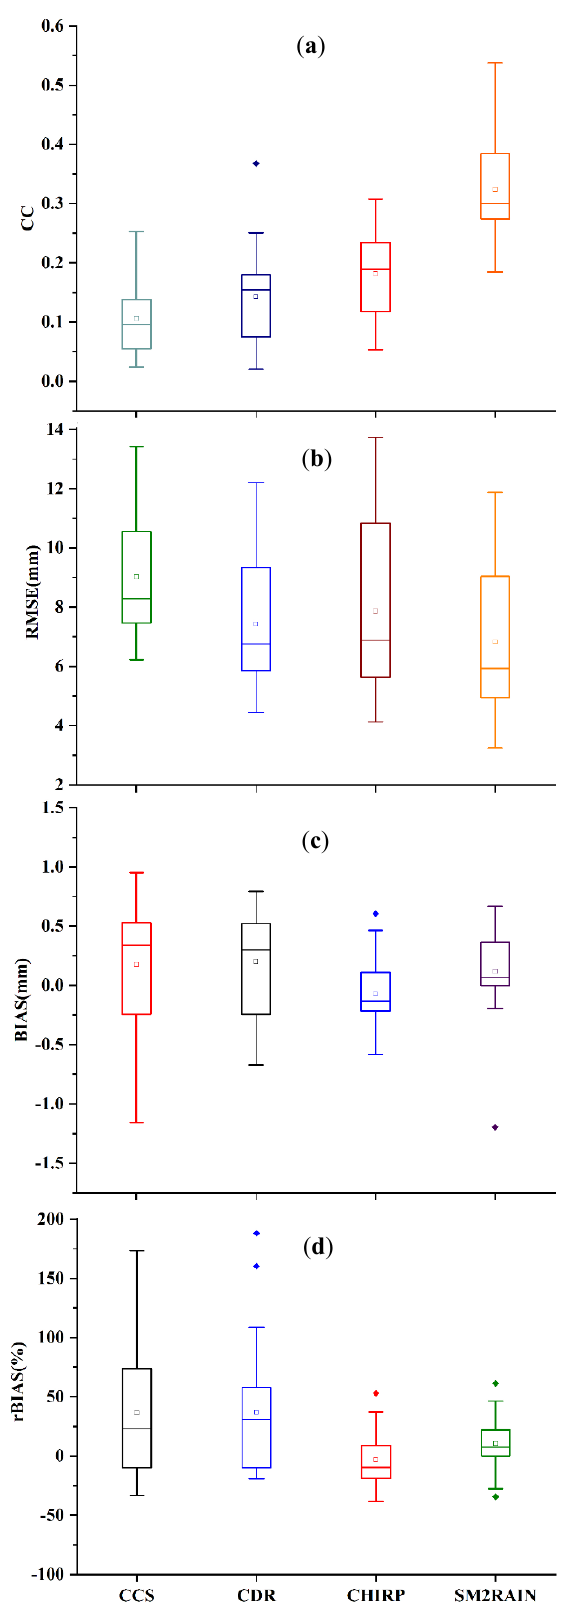
Figure 6. Box plots of the daily values of the ( a ) CC, ( b ) RMSE), ( c ) BIAS, and ( d ) rBIAS for the PERSIANN-CCS, PERSIANN-CDR, CHIRPS, and SM2Rain products.